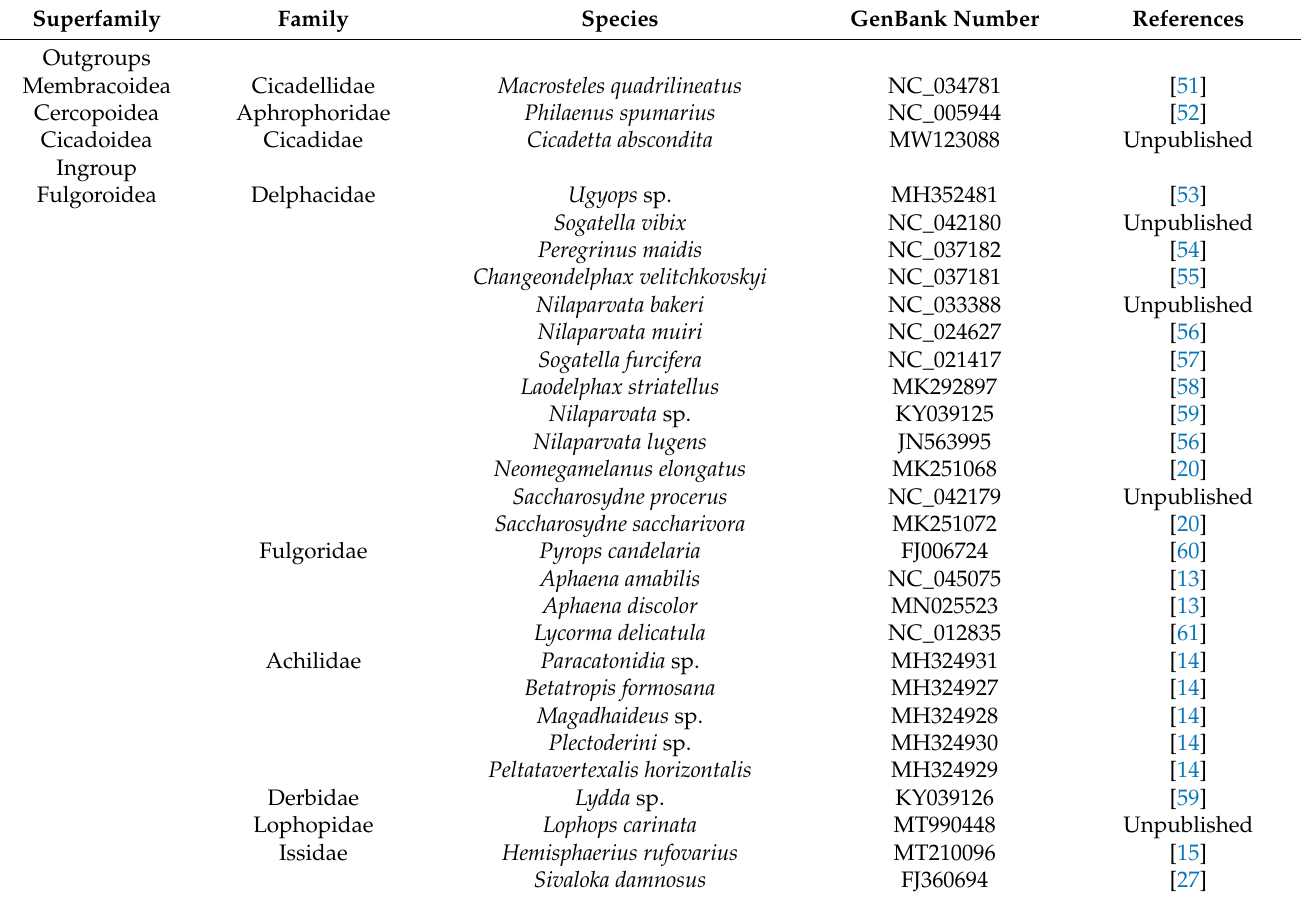
Table 1. Taxa used in this